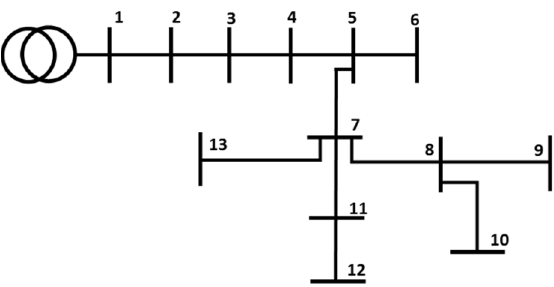
Figure 4. Modified IEEE 13-bus test distribution system used to validate the indices [34].